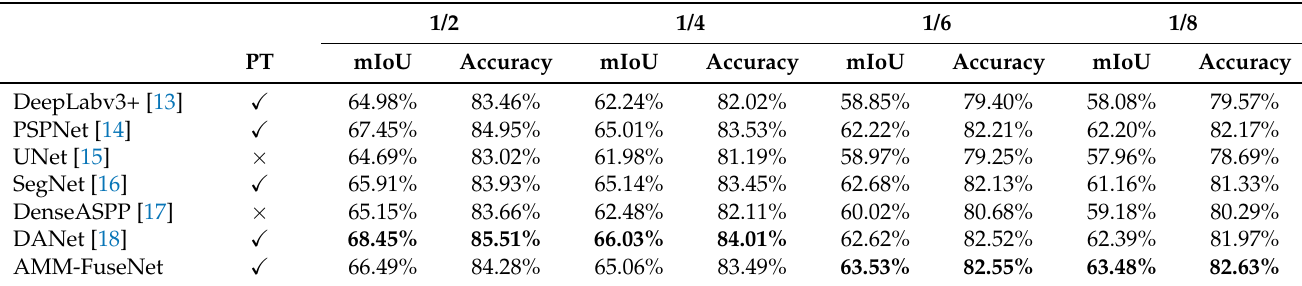
Table 11. Performance comparison of different methods on the Potsdam dataset for reduced training samples in terms of mIoU and accuracy ( (cid:88) : Initial backbone with pre-trained (PT) weights on ImageNet. × : Initial backbone Randomly).